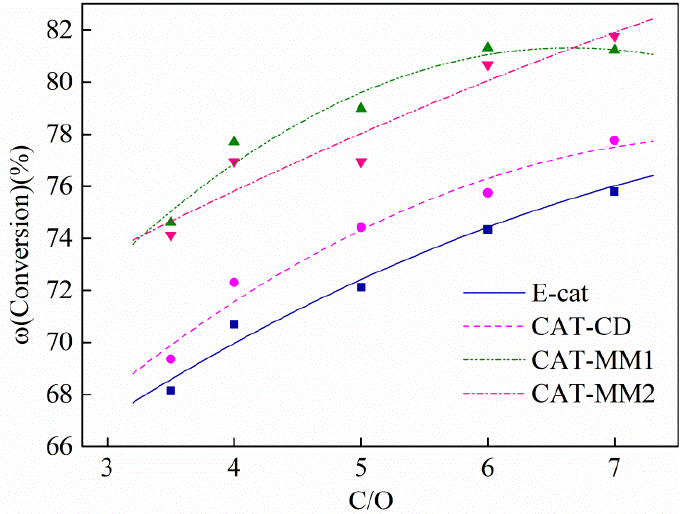
Figure 6. Conversion as a function of the catalyst-to-oil (C/O) ratio for different catalysts. The catalysts’ conversion increased with the increase of the C/O ratio. The adjustment of the C/O ratio could be realized by changing the catalysts’ addition amounts under a fixed feed injection quantity. An increased C/O ratio meant that more catalysts were added and more active centers were able to function in the reaction, which eventually led to the increase in